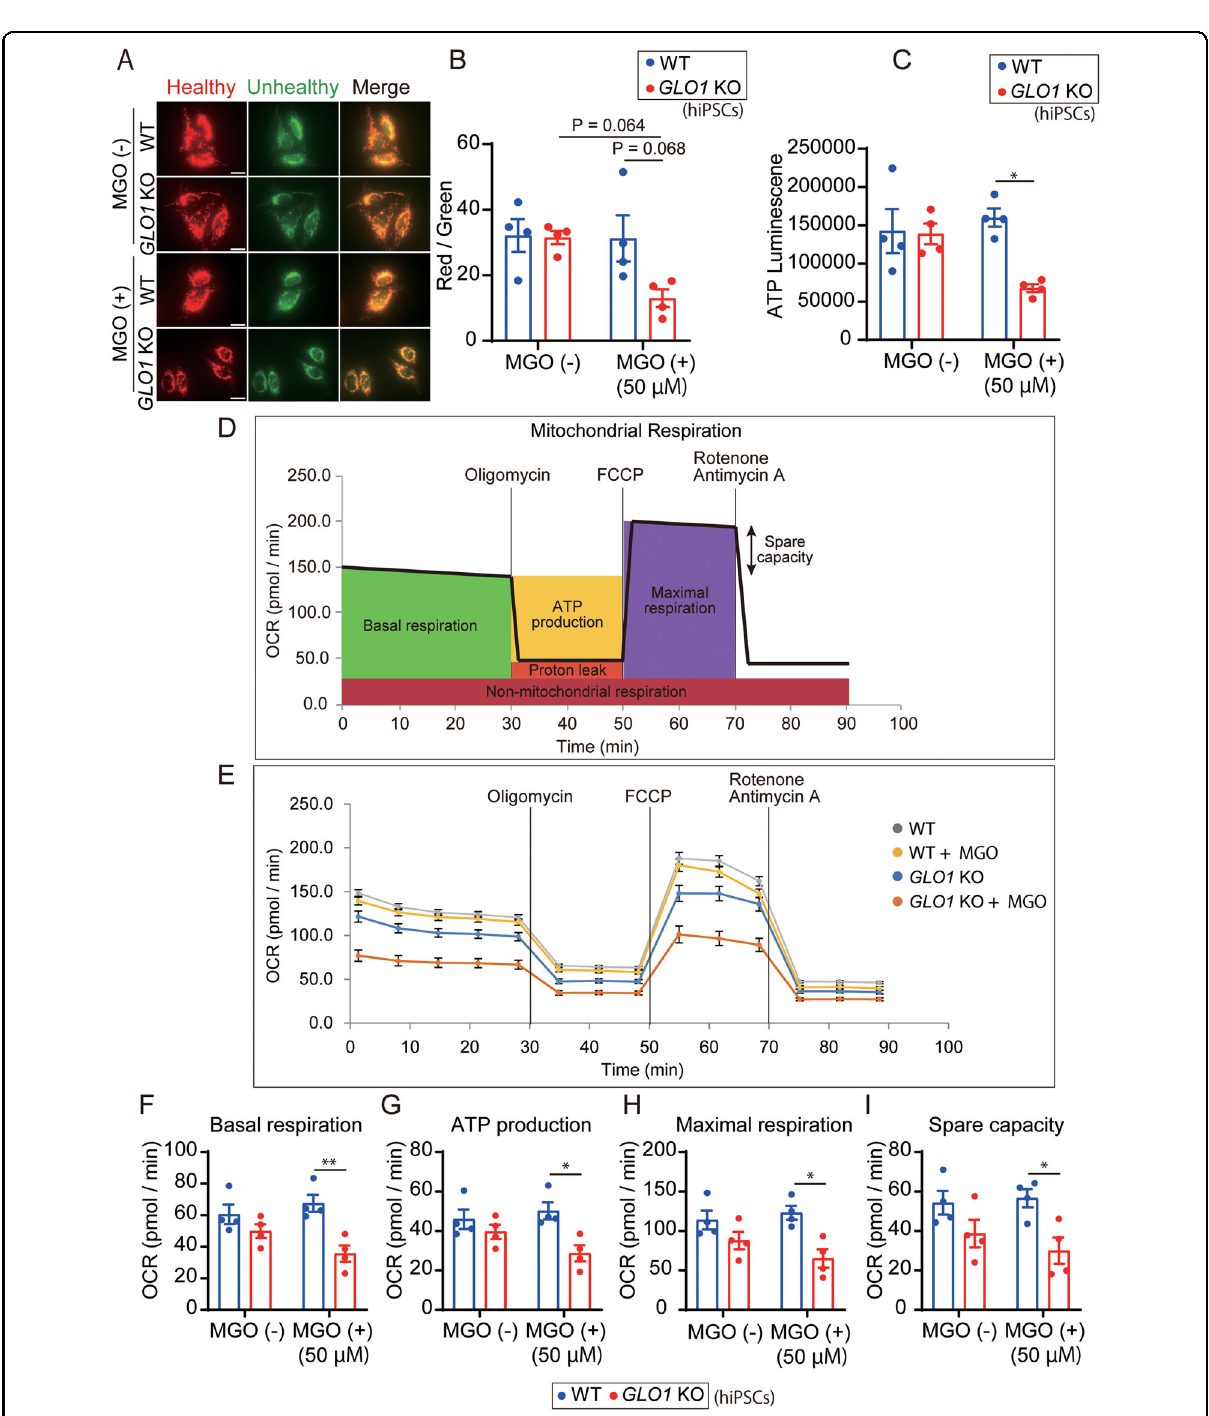
Fig. 3 Evaluation of mitochondrial function in WT- and GLO1 KO-hiPSCs after treatment with MGO. A , B JC-1 staining of WT- and GLO1 KO- hiPSCs after treatment with 50 µM MGO for 24 h. Scale bar: 50 µm. C Measurement of intracellular ATP contents in WT- and GLO1 KO-hiPSCs treated with 50 µM MGO for 24 h. Data were normalized to protein concentration. D Pro fi le of mitochondrial respiration analysis using Seahorse extracellular fl ux analyzer. Oligomycin, FCCP, and rotenone + antimycin A were serially administered. OCR oxygen consumption rate. E Plot of OCR in WT- and GLO1 KO-hiPSCs versus measurement time. MGO, treatment with 50 µM MGO for 24 h. Data were normalized to protein concentration. F − I Quanti fi cation of basal respiration ( F ), ATP production ( G ), maximal respiration ( H ), and spare capacity ( I ). GLO1 KO-hiPSCs showed signi fi cant reduction in respiratory function after treatment with 50 µM MGO. Data represent mean ± SEM. * P < 0.05, ** P < 0.01; two-way ANOVA, followed by Tukey ’ s multiple comparison